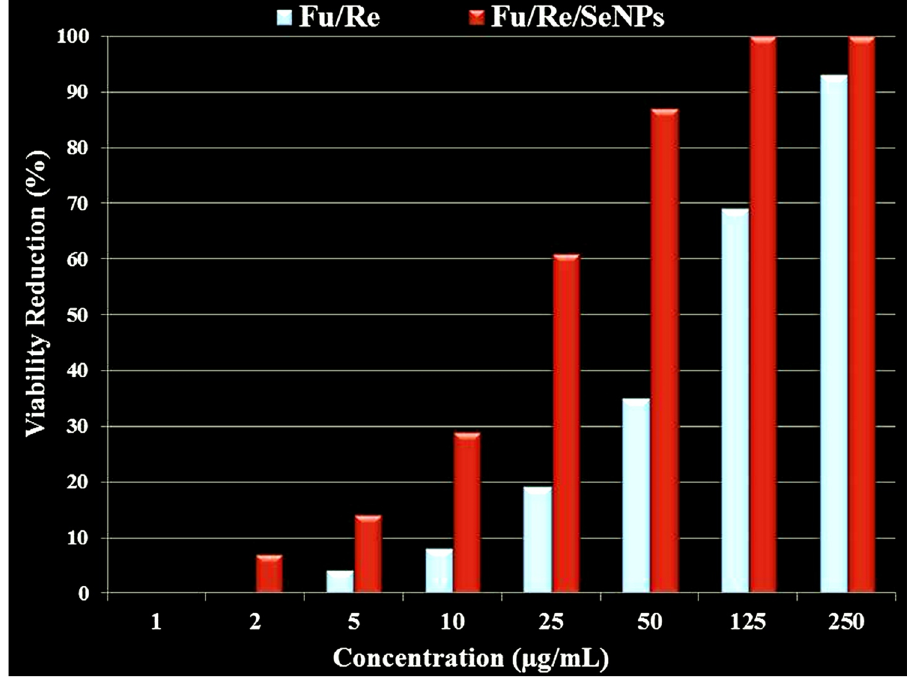
Figure 4: Cancer cells ’ ( HT - 29 ) viability using MTT assay after treatment with Fu/Re and Fu/Re/SeNPs